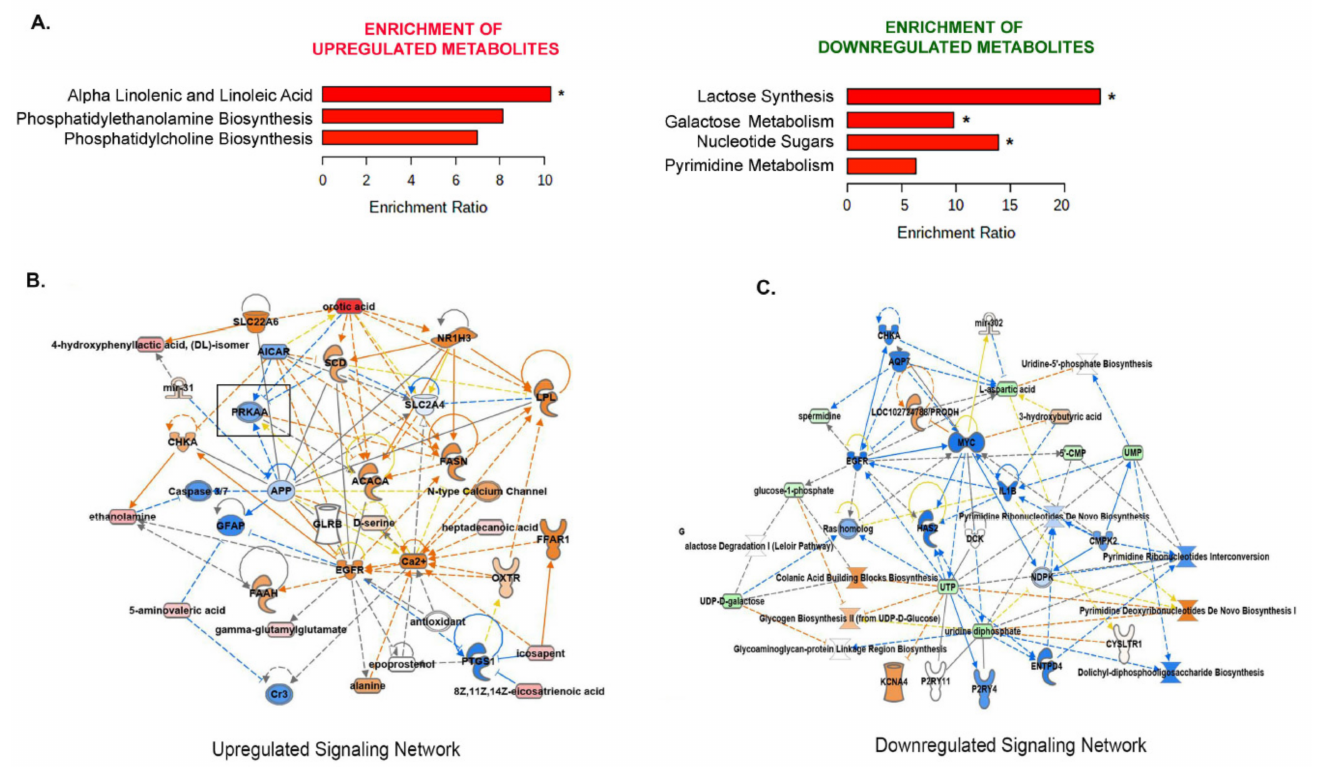
Figure 5. Enrichment analysis reveals commonly altered metabolic pathways in response to met- formin. ( A ) The consistently upregulated and consistently downregulated metabolites across all the three cell lines (* FDR < 0.05) were explored through enrichment analysis (MetaboAnalyst, SMDB pathways) to highlight concerted alterations. The significantly enriched metabolic pathways (FDR < 0.05) are presented. Ingenuity pathway analysis (IPA)-constructed network relationships and directional predictions about the relationships between consistently upregulated ( B ) or downregu- lated metabolites ( C ). Dark blue lines = predicted inhibition, dark orange = predicted activation. The blue and orange arrows show that the relationship is as expected for this prediction. Yellow arrows indicate that relation is not as expected. The observed metabolite fold change is in the shades of pink (up) and green (down)